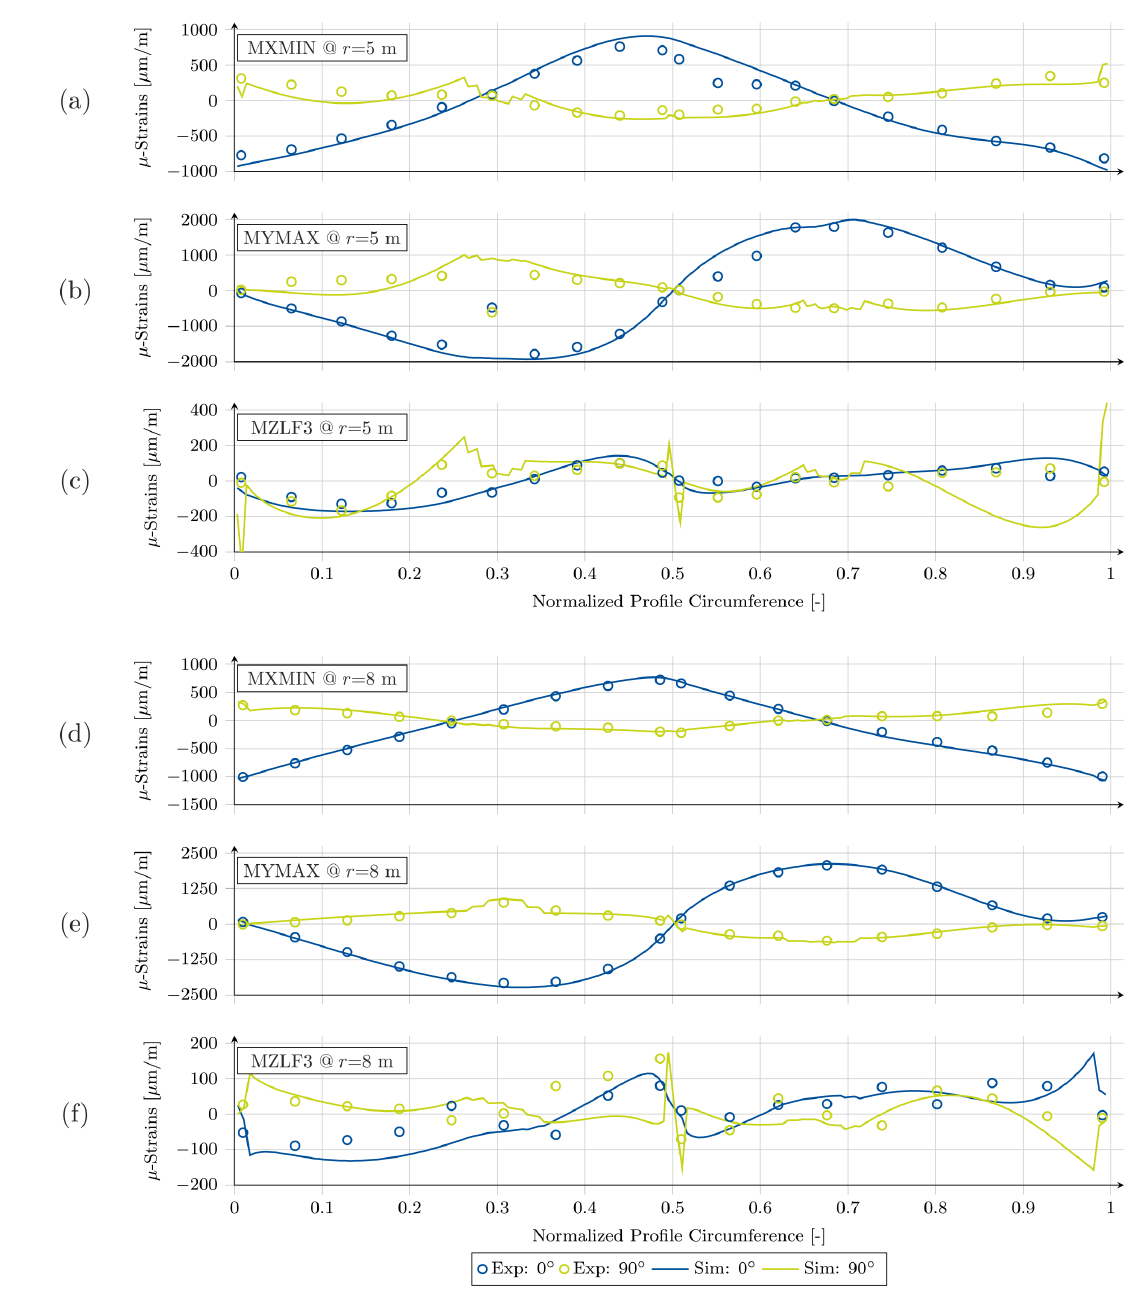
Figure 13. Spanwise and crosswise strains of the simulation and the test, plotted against the normalized profile circumference of the cross section at r = 5m for the (a) MXMIN, (b) MYMAX, and (c) MZLF3 load case and at r = 8m for the (d) MXMIN, (e) MYMAX, and (f) MZLF3 load